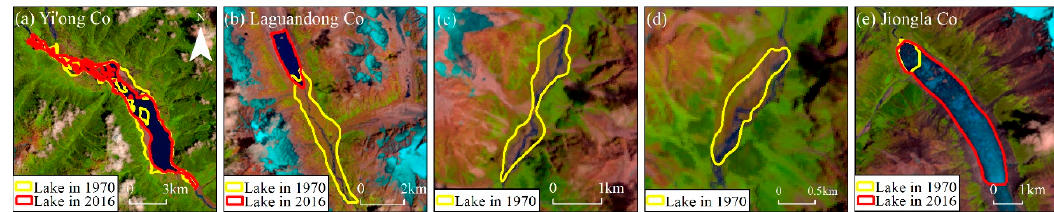
Figure 3. Changes of specific glacial lakes from 1970 to 2016 (the base maps were false color composite images of 6, 5, 4 bands of Landsat OLI, 2016).